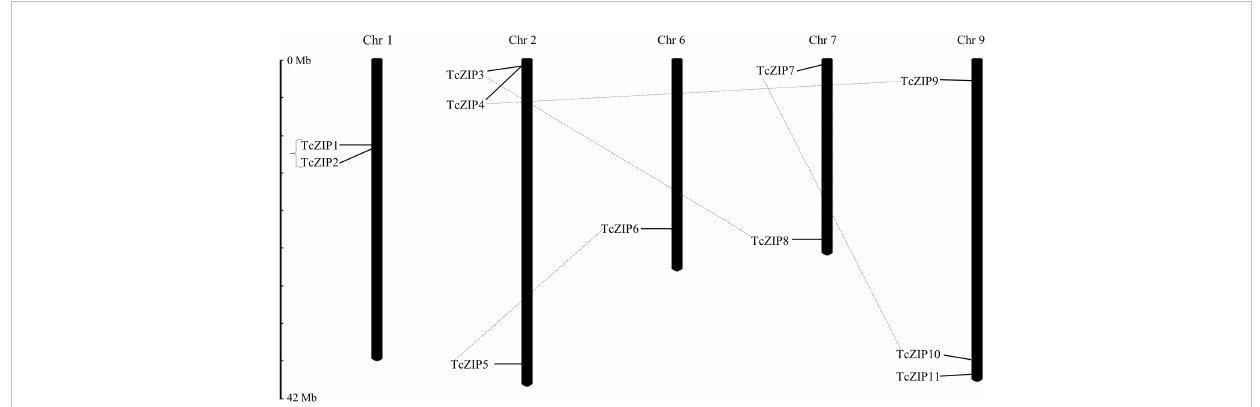
FIGURE 3 Chromosomal locations and TcZIP genes in cacao. The chromosomal positions of the TcZIP genes were mapped according to information available in Phytozome database. Chromosome numbers are indicated at the top of each chromosome. Genes with segmental duplication are represented by